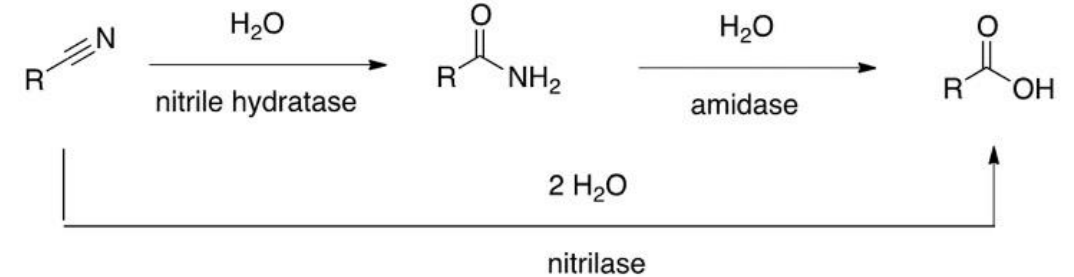
Scheme 1. Reactions catalysed by nitrile degrading enzymes.